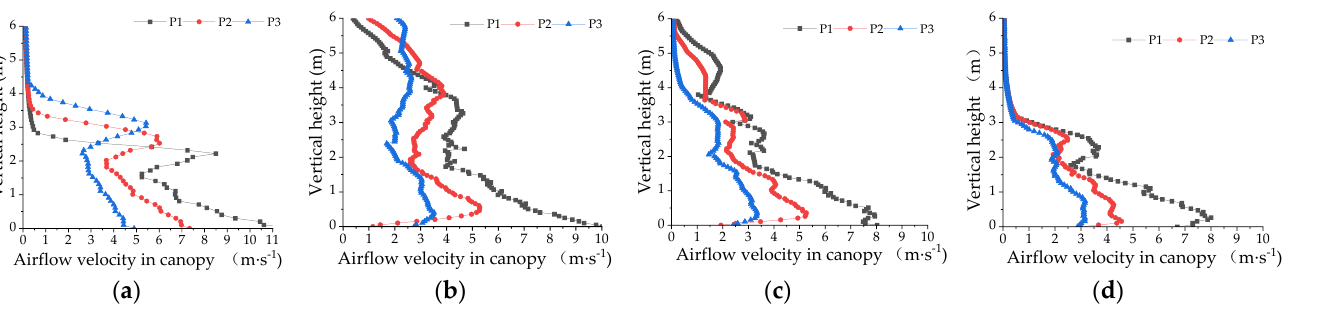
Figure 6. Distribution of air speed in the canopy at different driving speeds. ( a ) v = 0 m/s, ( b ) v = 0.5 m/s, ( c ) v = 1 m/s, ( d ) v = 1.5 m/s.